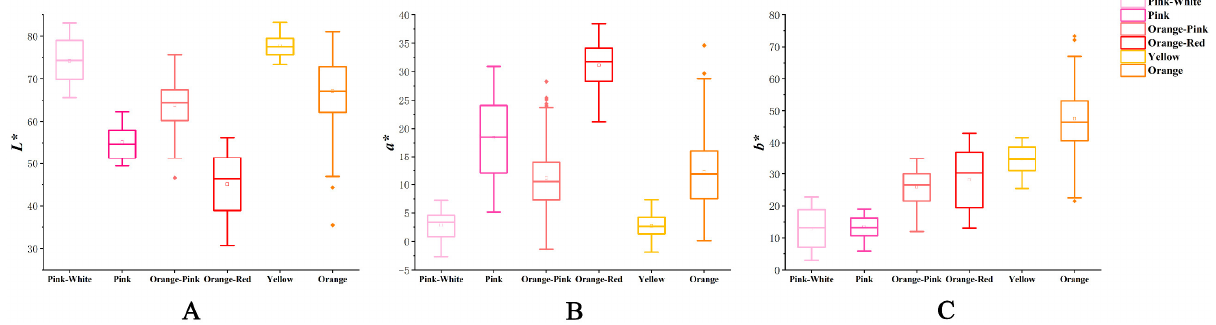
Figure 3. Box plots of different color groups for F1 hybrids with L* ( A ), a* ( B ), and b* ( C ) values. X - coordinate: 6 color groups; Y -coordinate: color space value L* , a* , and b*. X -coordinate: 6 color groups; Y -coordinate: color space value L* , a* , and b*